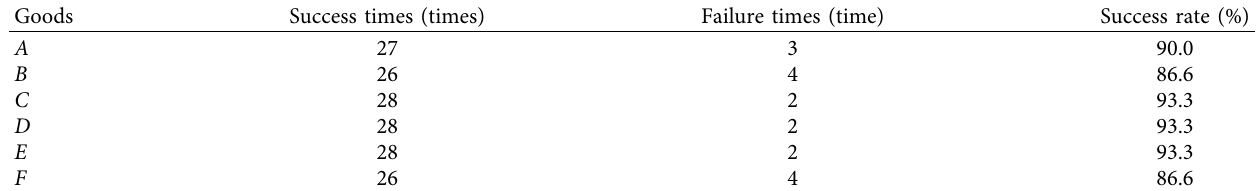
Table 3: Results of static capture experiment of the method in literature [4].